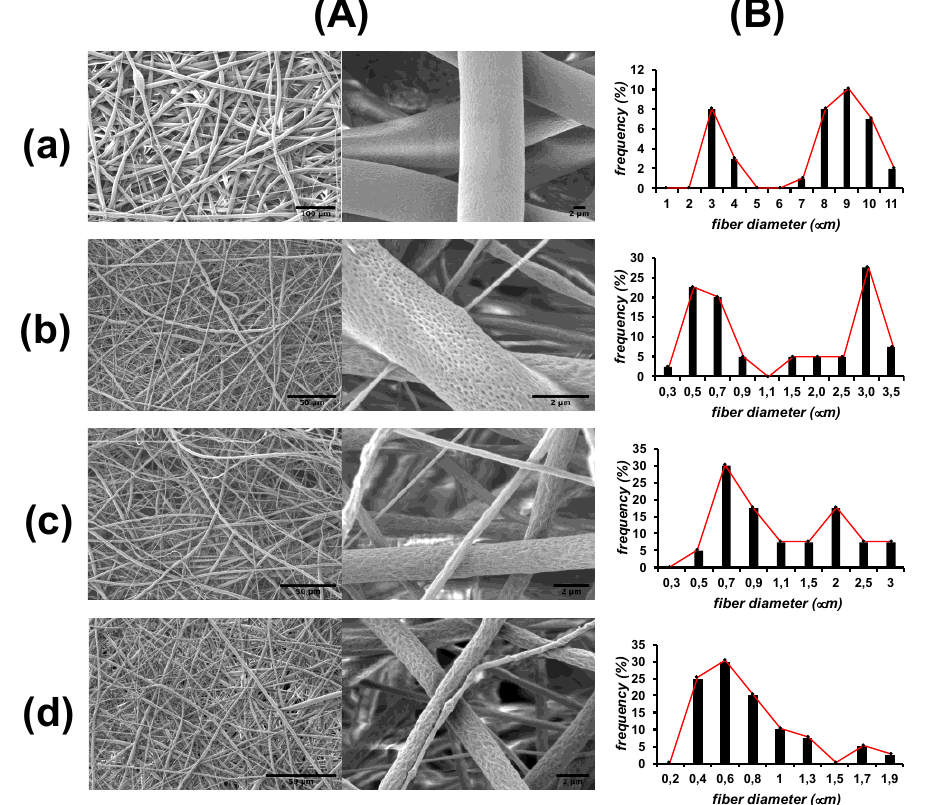
Figure 2. ( A ) SEM images and ( B ) fiber diameter distribution corresponding to fibers of poly( ε -caprolactone) (PCL 394 ) prepared in the absence ( a ), and in the presence of 2.5 wt% of poly(ethylene oxide) m -block- poly( ε -caprolactone) n (PEO m -b-PCL n ) PEO 45 -b- PCL 11 , ( b ), PEO 148 -b- PCL 13 ( c ), and PEO 230 -b- PCL 184 ( d ).